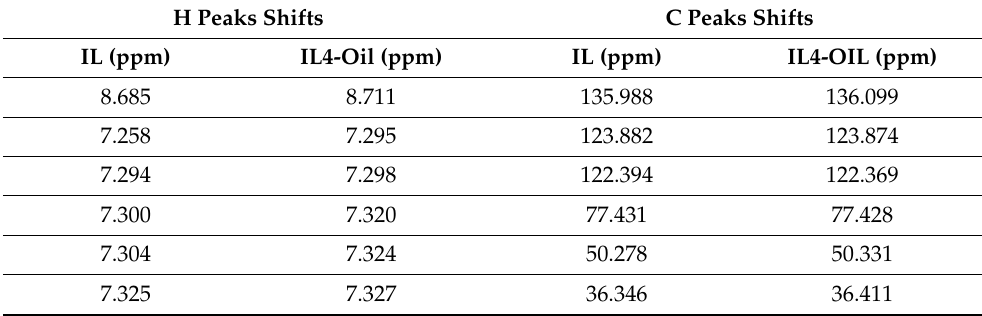
Table 5. NMR peaks shifts for 1H and 13C spectra for IL4 before and after the oil extraction. H Peaks Shifts C Peaks